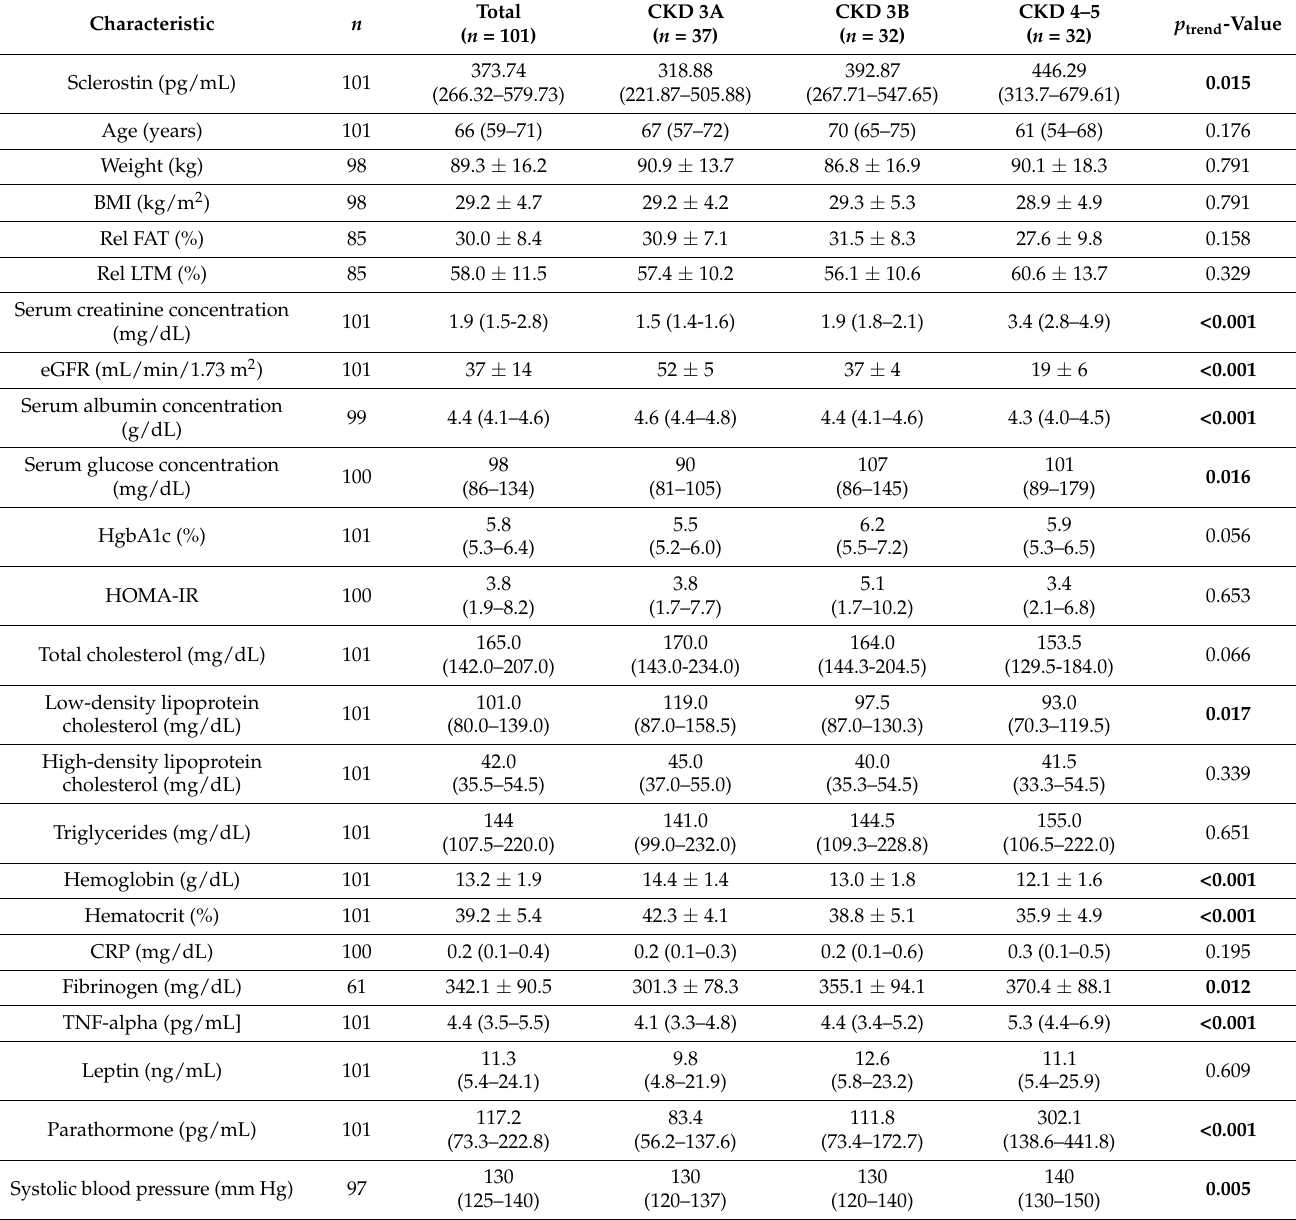
Table 1. Clinical characteristics of the study